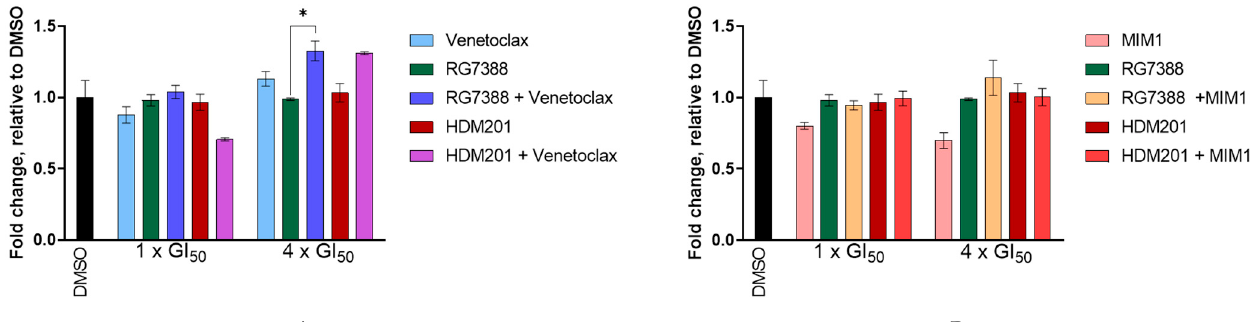
Figure 11. Caspase-3/7 catalytic activity in MES-SA cells following 24 h treatment with ( A ) Venetoclax and or RG7388/HDM201; ( B ) MIM1 and or RG7388/HDM201, assessed by Caspase-Glo 3/7 assay. Data are presented as the mean fold change relative to DMSO control, calculated from three independent repeats. Statistical significance was evaluated by one-way ANOVA with Tukey’s post hoc test for multiple comparisons, * p ≤